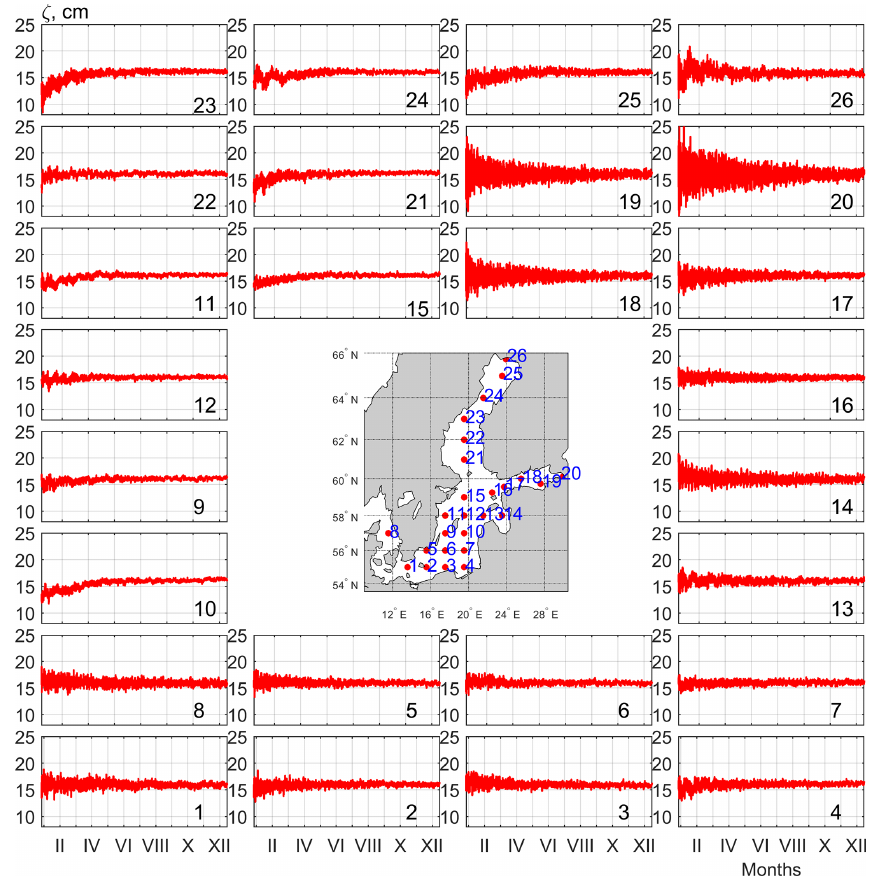
Figure 4. Time series of free barotropic sea level oscillations at selected points simulated by INMOM. Locations of points are shown on the map.